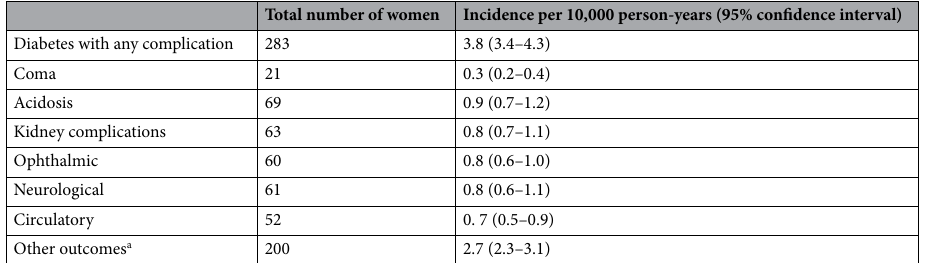
Table 2. Incidence rates of hospitalization for type 2 diabetic complications among women with gestational diabetes mellitus, within 10 years of delivery, Quebec, 1989 to 2018. N = 90,143. a Foot ulcer, multiple complications, and unspecified